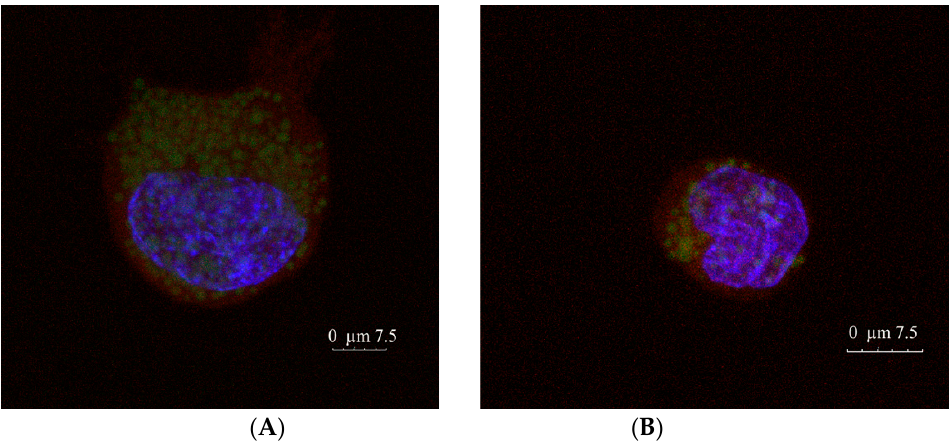
Figure 7. Confocal microscopy images of ( A ) Blank and ( B ) RFB-loaded NLC macrophages uptake. Red, blue, and green colours represent cell cytoplasm (Alexa Fluor™ 647 phalloidin), cell nuclei (DAPI) and NLC formulations (Coumarin 6), respectively.